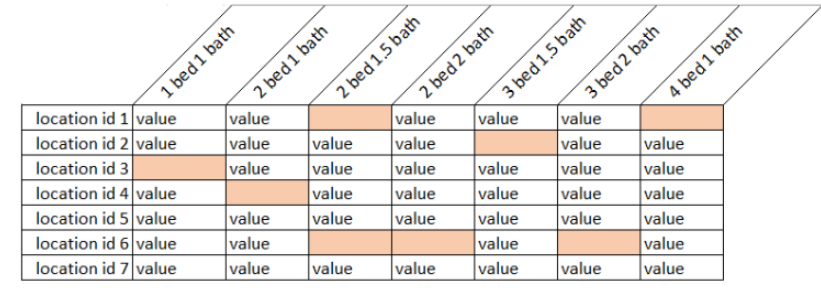
Figure 5. Housing Price Matrix